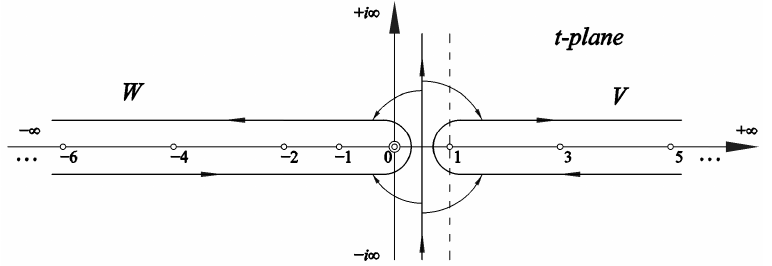
(cid:82) ε + i ∞ I 2 ( t ) dt and the poles on the real axis. ε − i ∞ 16 π 3 i (cid:82) ε + i ∞ I 2 ( t ) dt can be deformed to W (leftward) and V ε − i ∞ 16 π 3 i